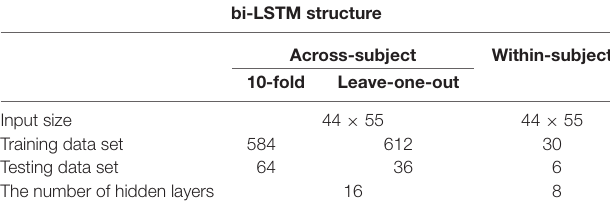
TABLE 2 | A single bi-LSTM